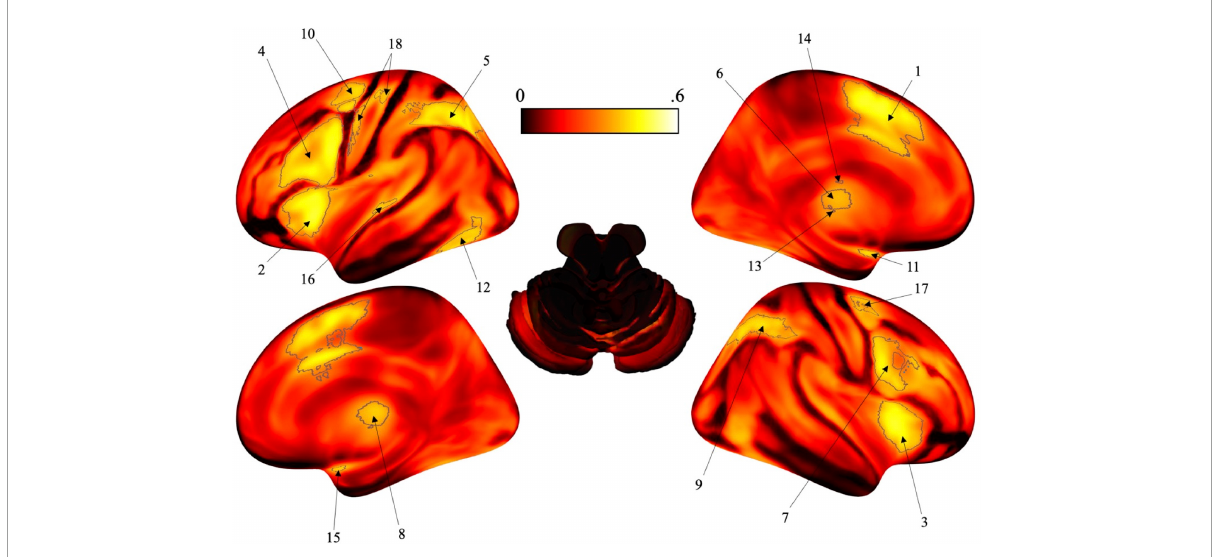
FIGURE1 Surface brain renderings of the activation likelihood estimation (ALE) maps. Gray contours represent the areas that have a posterior probability of 0.4 or greater. To note, these posterior probabilities reflect the probability of each individual voxel, not the probability of a cluster (or region) being activated. (1) Left posterior-medial frontal gyrus (SMA). (2) Left insula lobe. (3) Right insula lobe. (4) Left inferior frontal gyrus (pars opercularis). (5) Left angular gyrus. (6) Left thalamus. (7) Right inferior frontal gyrus (pars opercularis). (8) Right thalamus. (9) Right angular gyrus. (10) Left pre-central gyrus. (11) Left amygdala. (12) Left fusiform gyrus. (13) Left putamen. (14) Left caudate nucleus. (15) Right amygdala. (16) Left middle temporal gyrus. (17) Right pre-central gyrus. (18) Left post-central gyrus.